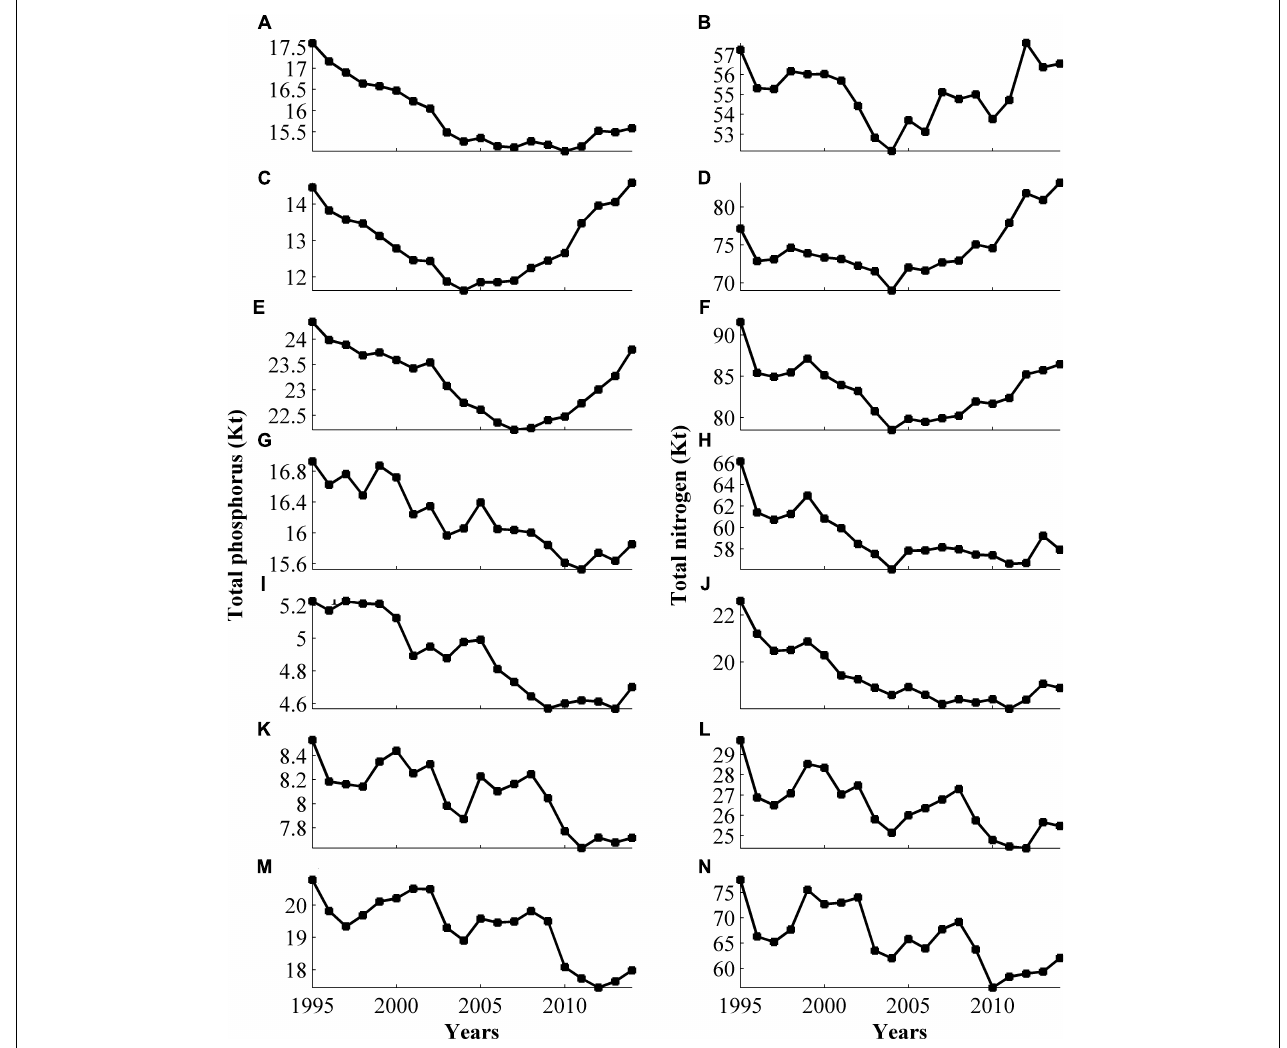
FIGURE 4 | Annually averaged nutrient reservoirs in the Bothnian Bay (A,B) , the Bothnian Sea (C,D) , the Northern Baltic Sea (E,F) , the East Coast (G,H) , Gotland (I,J) , the South Coast (K,L) , and the West Coast (M,N) , expressed in Kt. The reservoir is the sum of the vertically integrated pelagic and benthic nutrient in dissolved inorganic, and organic and particulate organic